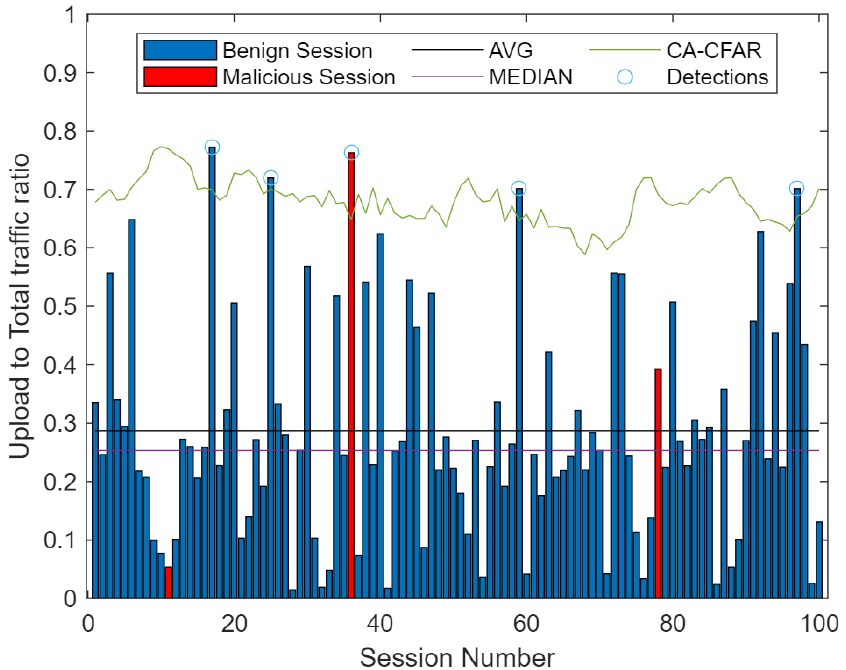
Figure 19. The designated threshold for 40 training cells and 4 guards cells. Upload ratio. As can be seen from the figures, lower values of training cells result in the decision threshold being more aggressive. On the other hand, higher values of training cells flatten the chosen decision threshold, so the detection concerns only the highest values from the chart. As for the values of guard cells, their impact on detection is relatively small. Guard cells only gently influences the shape of the decision